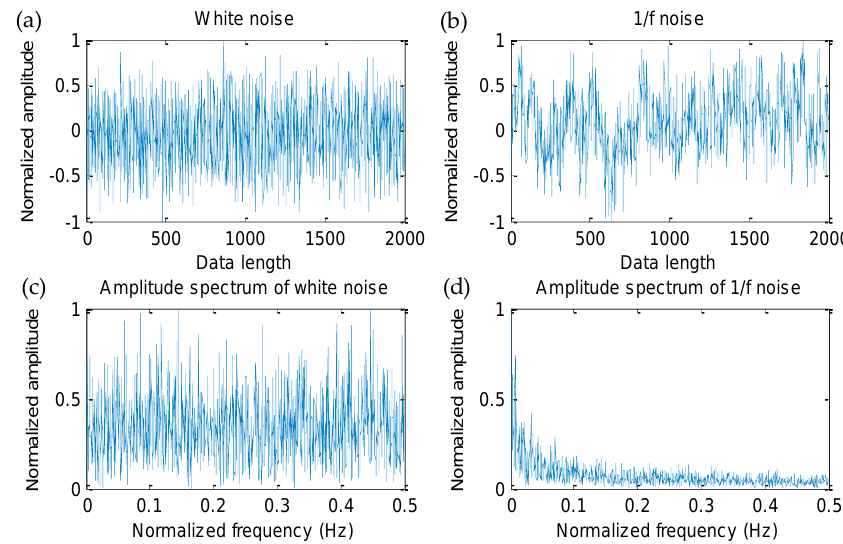
Figure 4. Waveform and amplitude spectrum of two noise signals: ( a ) waveform of white noise, ( b ) waveform of 1/f noise, ( c ) amplitude spectrum of white noise, ( d ) amplitude spectrum of 1/f noise.